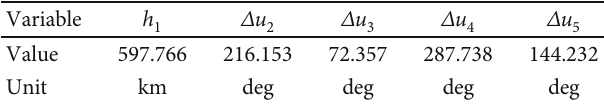
Figure 7: Best and mean fi tness in each generation. Table 4: Values of design variables.